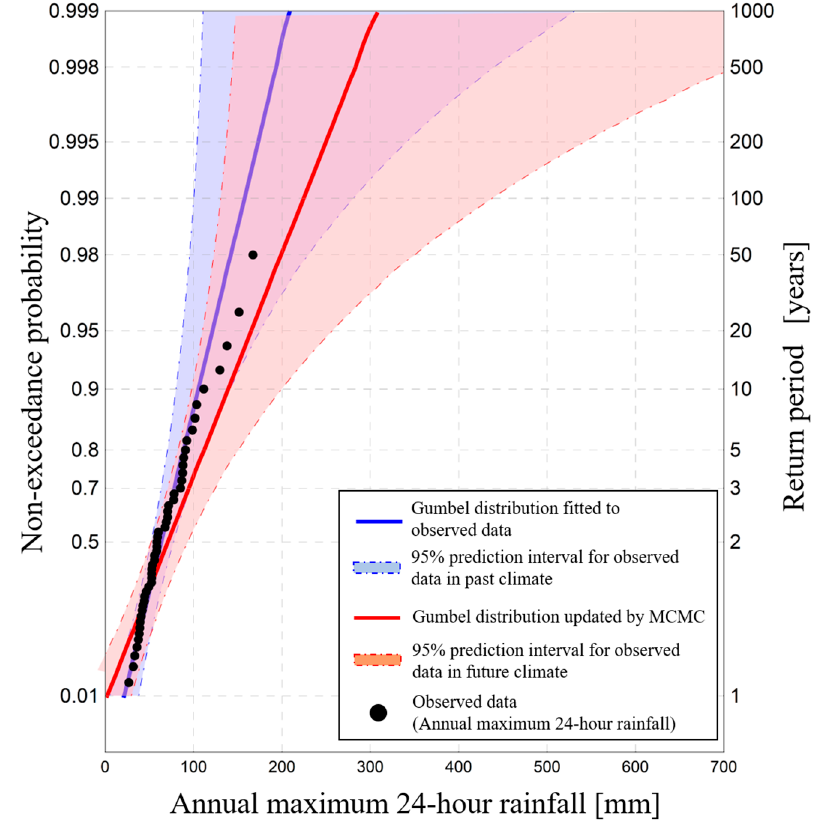
Figure 22. Update of prediction interval using Bayesian method assimilating ensemble high-resolution climate projection database.